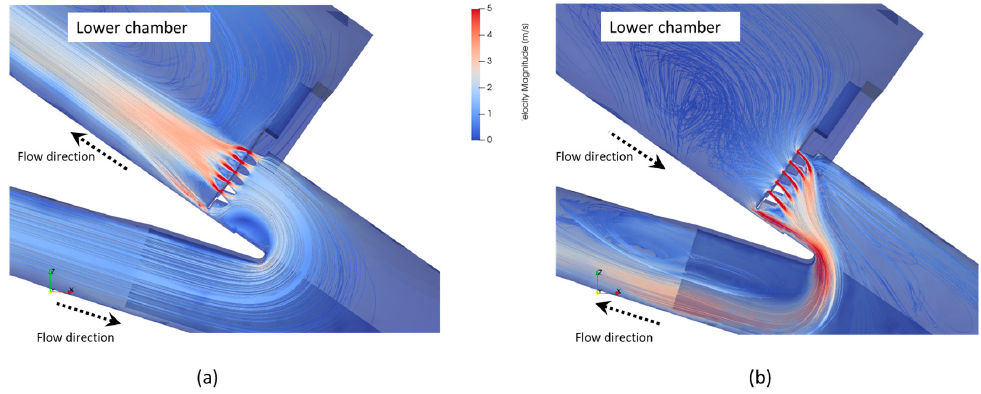
Figure 5. Velocity streamlines during mass oscillation: ( a ) flow into the surge tank (direction C–A); ( b ) flow exiting the surge tank (direction A–C) (Q = 5 m 3 /s) .